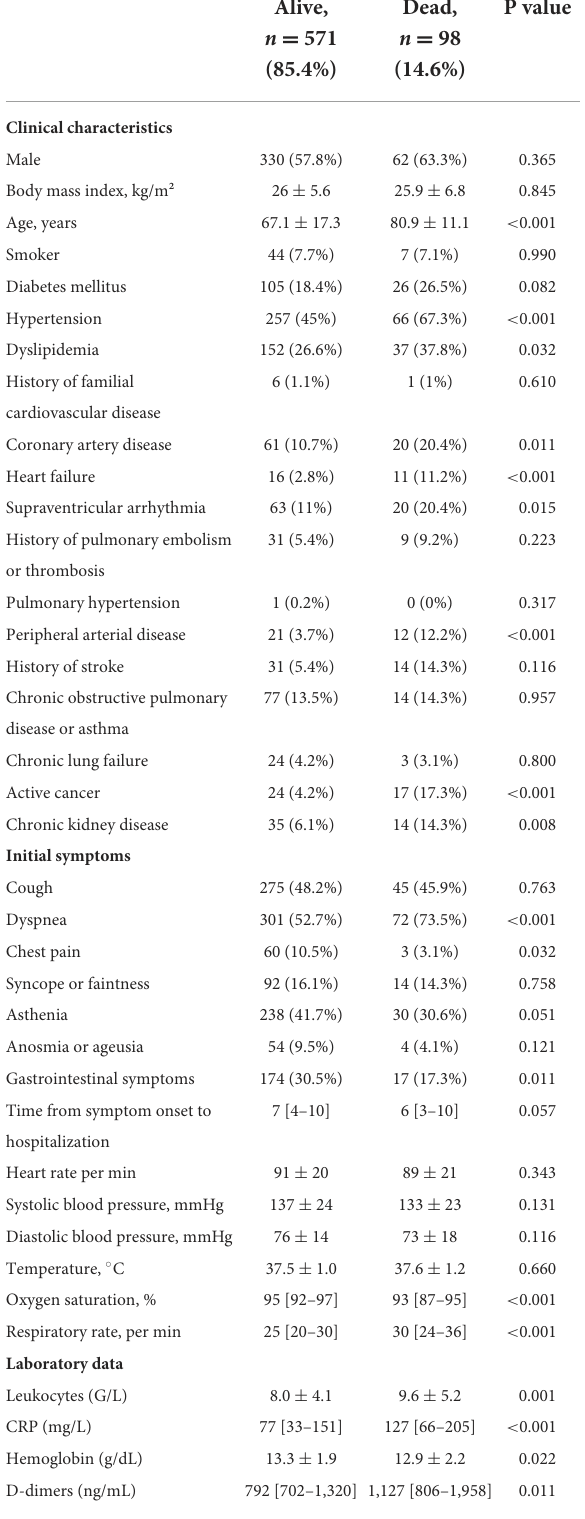
TABLE 1 Baseline characteristics of the study population presenting with